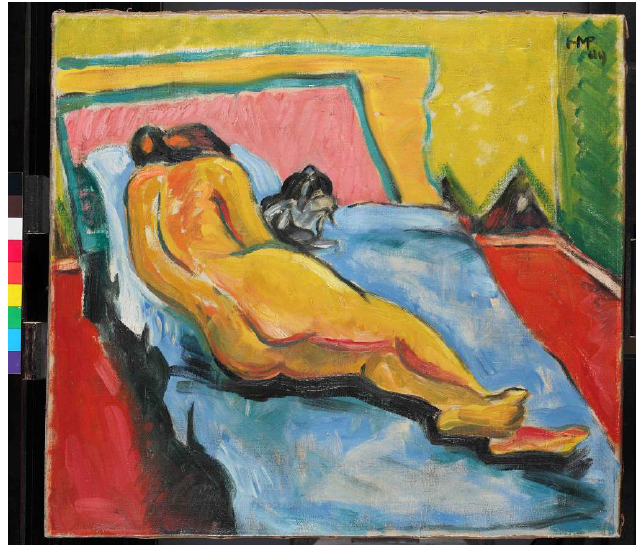
Figure 2. Painting allegedly attributed to Hermann Max Pechstein (1881–1955), “Liegender weiblicher Akt mit Katze” (1909); signature on upper right: “HMP 1909”; oil on canvas; stretcher frame, H 55.4 cm × B 60.2 cm (photo: Christoph Schmidt).